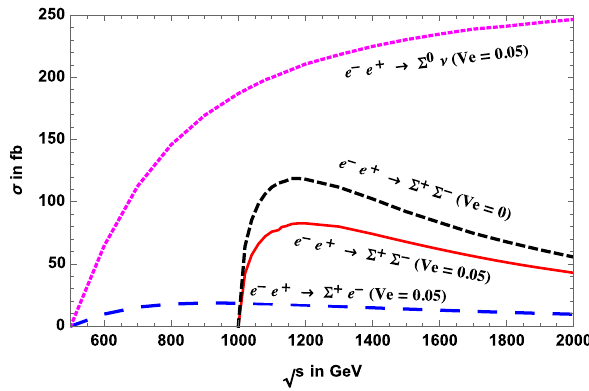
Fig. 2 Cross section for e + e − → (cid:2) 0 ν, (cid:2) ± e ∓ , (cid:2) + (cid:2) − against the centre-of-mass energy, with M (cid:2) = 500 GeV